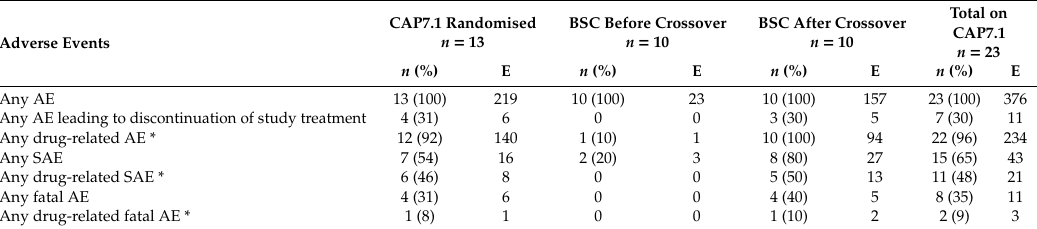
Table 4. Adverse events (AEs) in the safety analysis set who received CAP7.1. Adverse